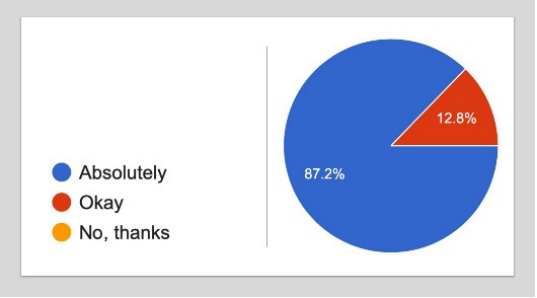
Figure 7. Willingness of students to join other similar